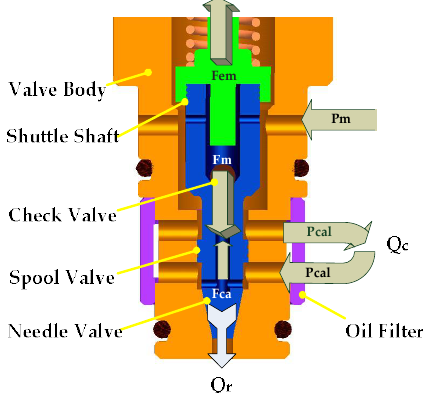
Figure 18. Proportional valve body construction and fluid force.